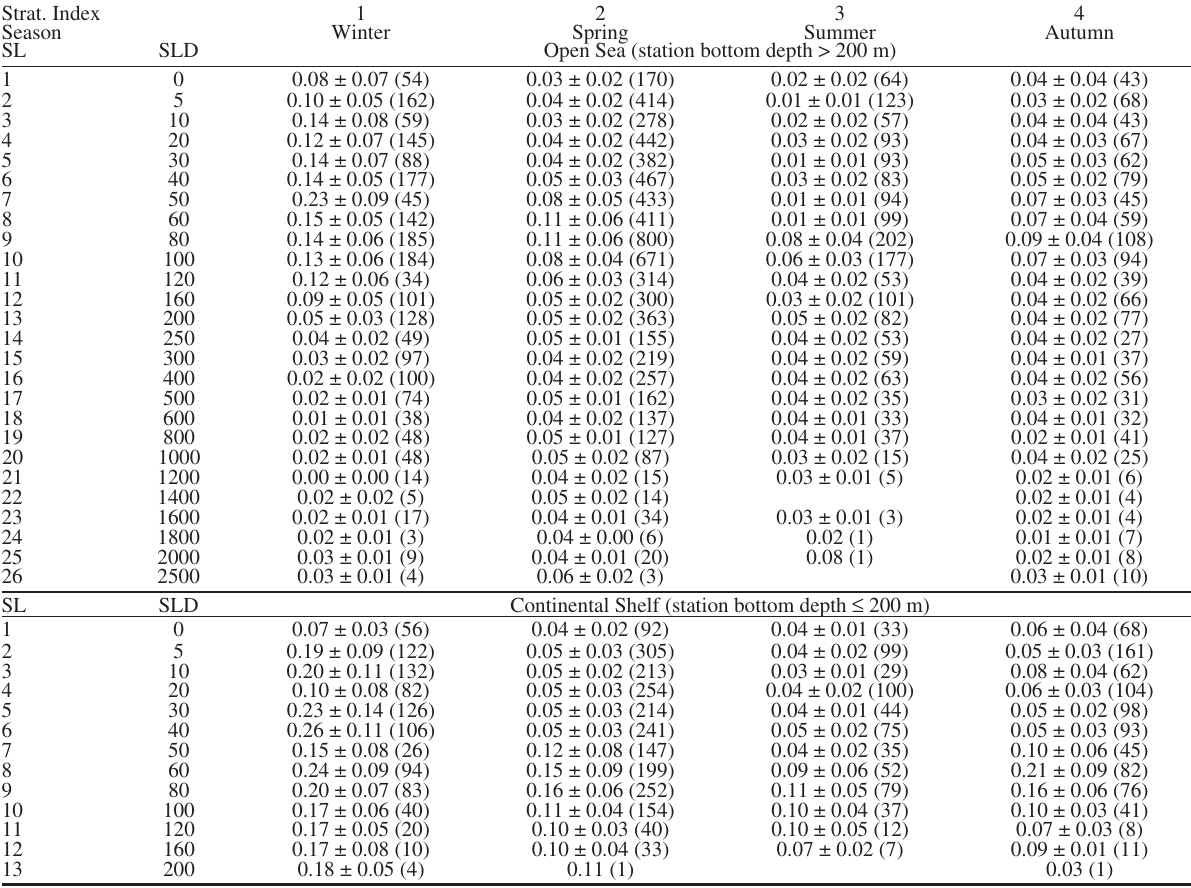
Table S4. – Nitrite concentration (μM) with depth and stratification of the water column in the Catalan Sea (NW Mediterranean Sea). Shown are median ± median absolute deviation (number of data between parentheses). SL, Standard Level; SLD, Standard Level Depth (m). Strat. Index